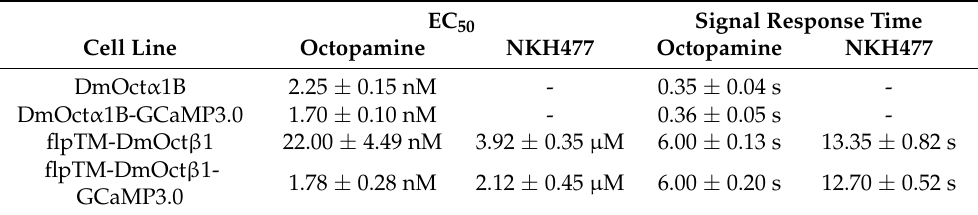
Table 2. EC 50 values and signal response times at saturating octopamine and NKH477 concentrations are summarized for DmOct α 1B- and flpTM-DmOct β 1-receptor-expressing cells loaded with Fluo-4 or constitutively expressing GCaMP3.0. Values represent mean ± SEM (triplicate determination for each data point) from three independent